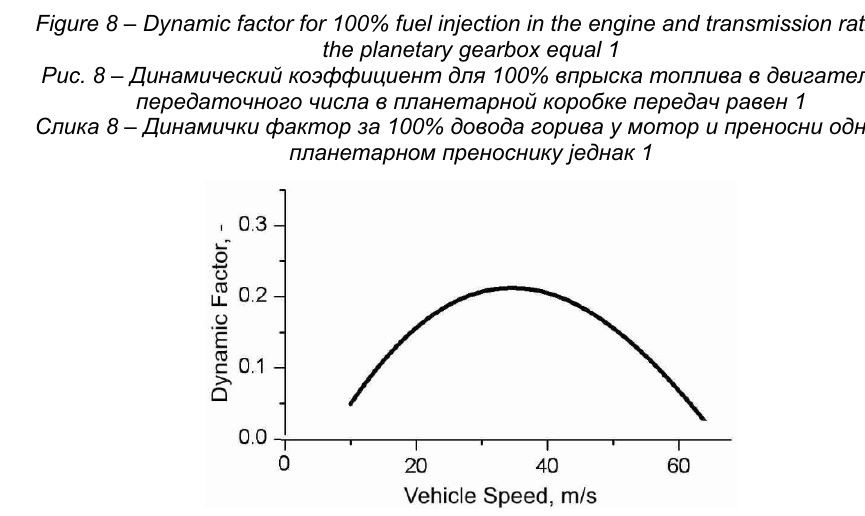
Figure 9 – Dynamic factor for 75% fuel injection into the engine and transmission ratio of the planetary gearbox equal